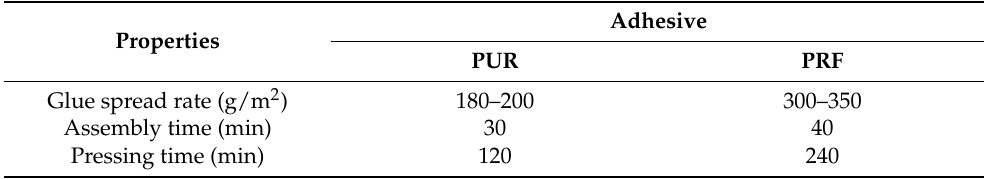
Table 2. Typical properties of two commercial structural adhesives.